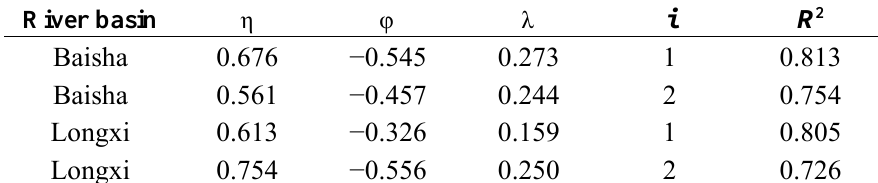
Table 2. Parameters of Equation (2) in river basins.